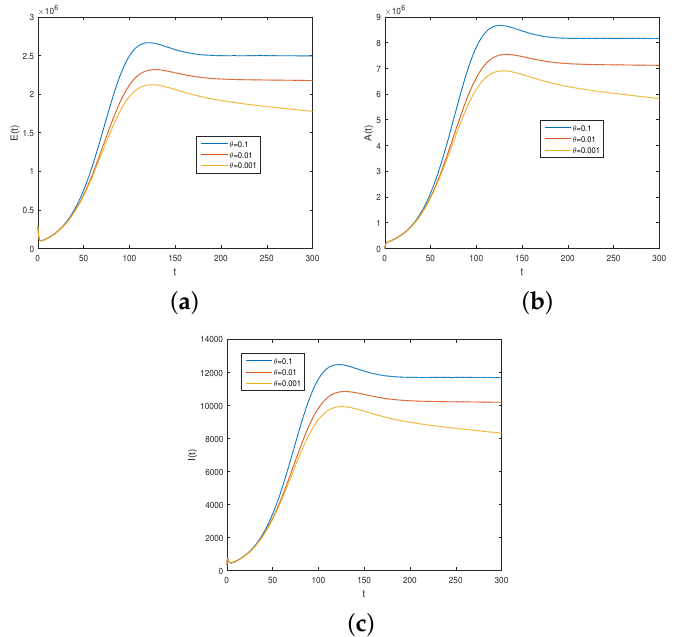
Figure 9. Impact of the natural loss of immunity on infected compartments, θ with η = 0.95. Subfigures ( a – c ) describes the dynamics of exposed, asymptomatic, and symptomatic individuals